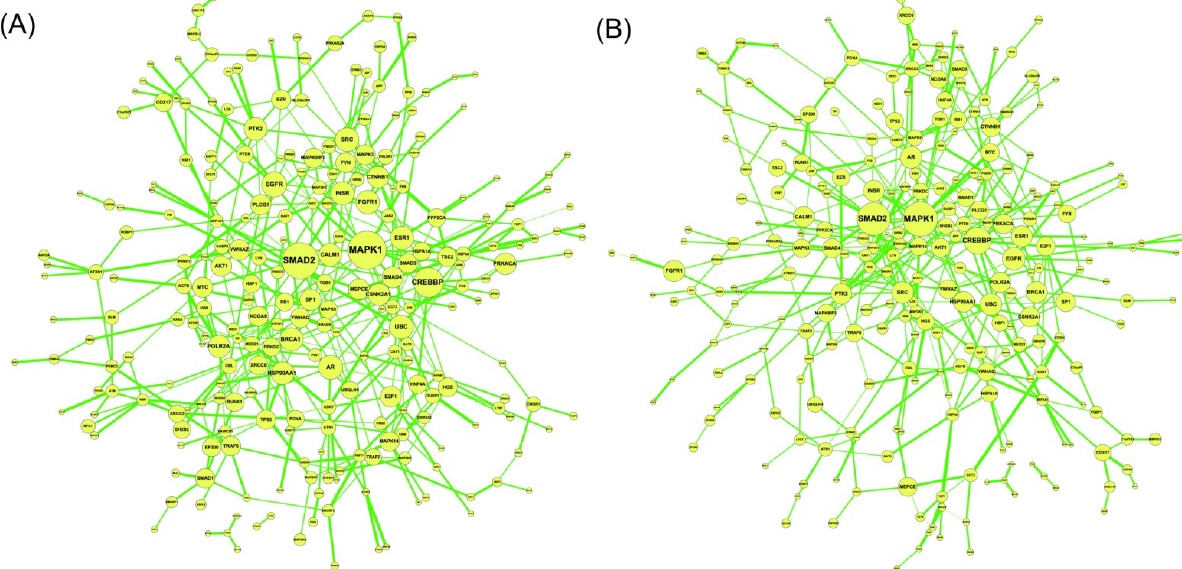
Figure 5. The constructed network-based biomarker. ( A ) Cancer protein association network (CPAN) obtained from C in (2.18) by maximum likelihood estimation, Akaike’s information criterion (AIC) selection, and Student’s t-test. ( B ) Non-cancer protein association network (NPAN) obtained from N in Equation (2.18) using the same criteria.